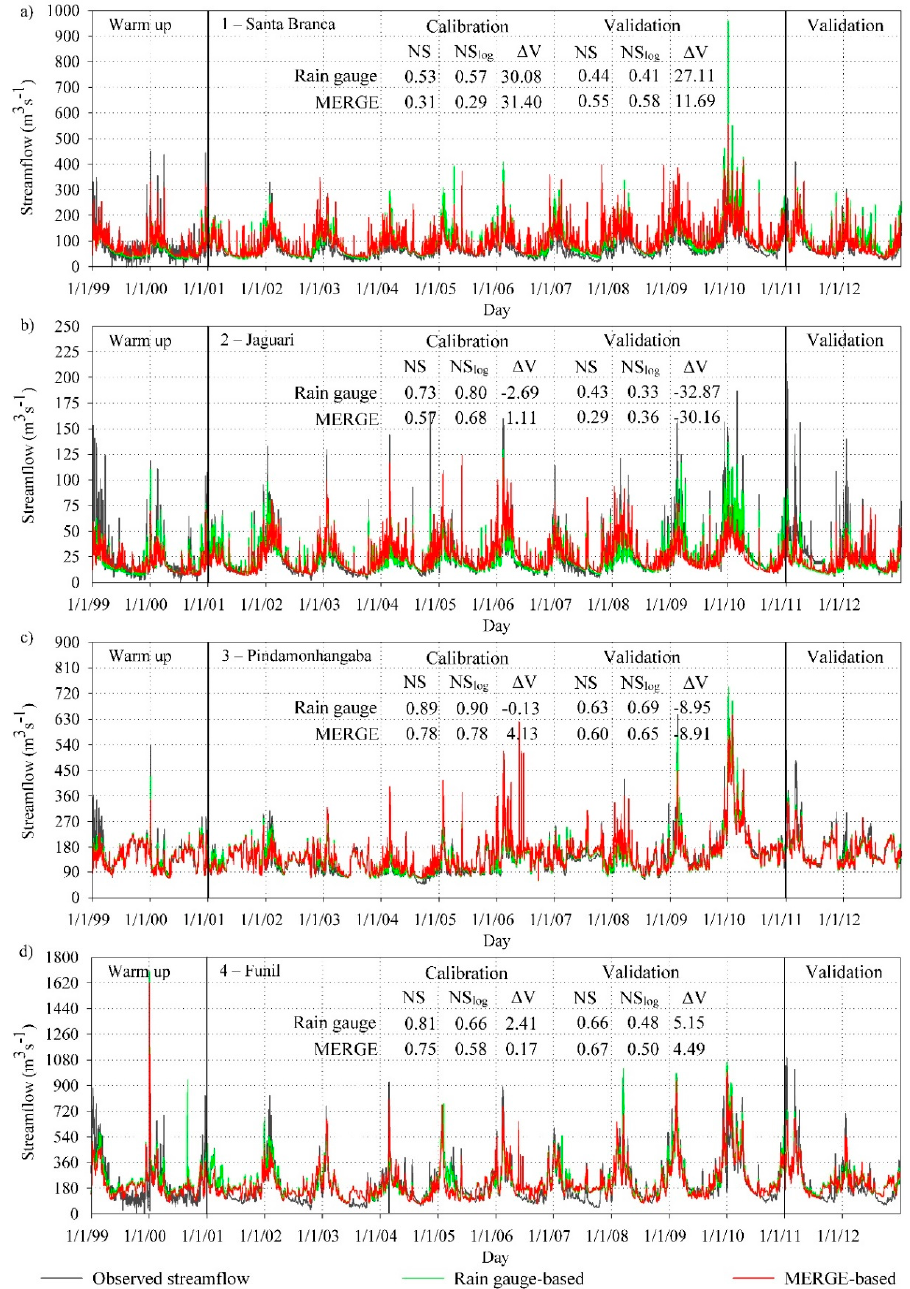
Figure 8. Observed and simulated streamflow for watersheds 1 to 4 for watersheds ( a ) 1, ( b ) 2, ( c ) 3, and ( d )